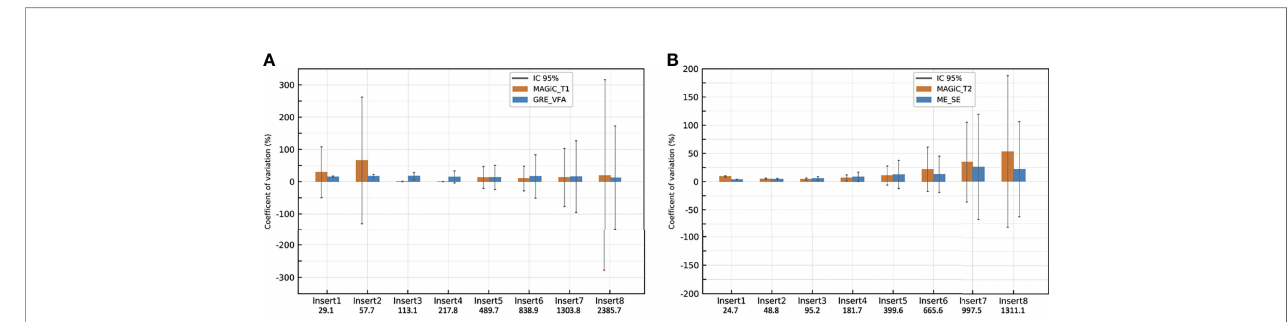
FIGURE 6 | Coef fi cients of variation of the repeated measurements ( n = 15) with the head and neck unit (HNU) coil of T 1 mappings for MAGiC ® and gradient echo with variable fl ip angle (GRE-VFA) (A) and T 2 mapping for MAGiC ® and multi-echo spin echo (ME-SE) (B) . Vertical lines show the 95% con fi dence intervals.